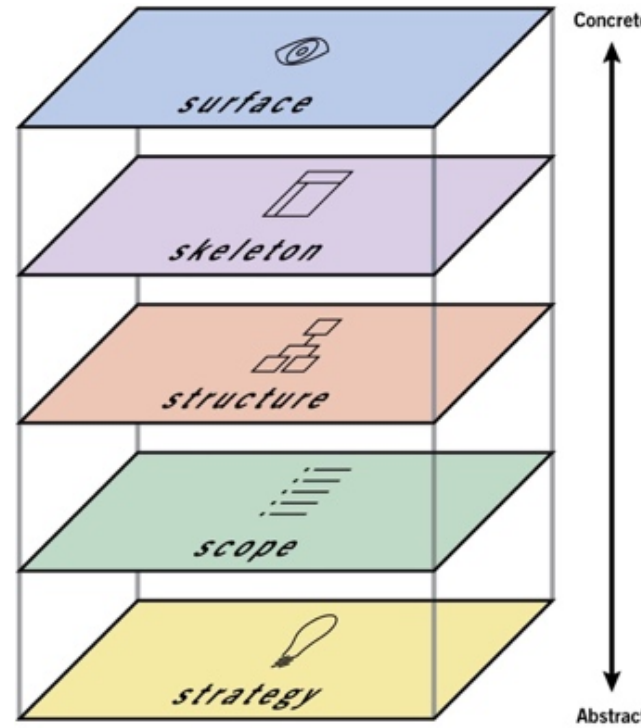
Figure 1. Jesse James Garrett’s 5-Planes of UX Design.